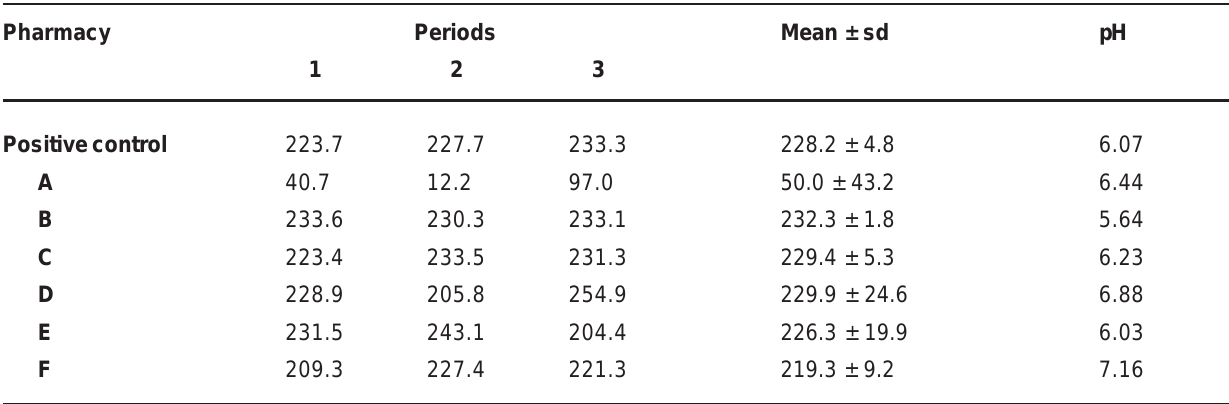
TABLE 1- Fluoride concentration* (µg/mL) found in the 3 formulas of the mouthrinses in each of the periods and mean (± standard deviation) and pH of the mouthrinses purchased in the 3 rd